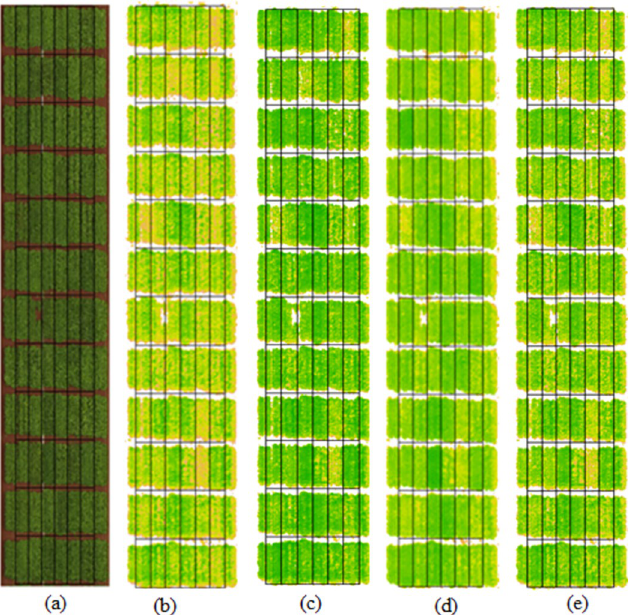
Fig 5. The RGB orthomosaic of the peanut field acquired at DAP-96 used in this study a), and its corresponding shape-file overlayed on the VI images b) DVI, c) SAVI, d) NDRE e) LAI.